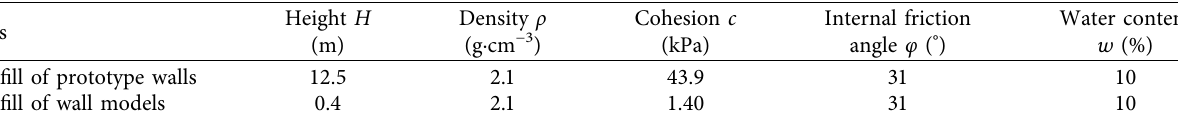
Table 2: Main physical and mechanical parameters of prototype soil and model materials.